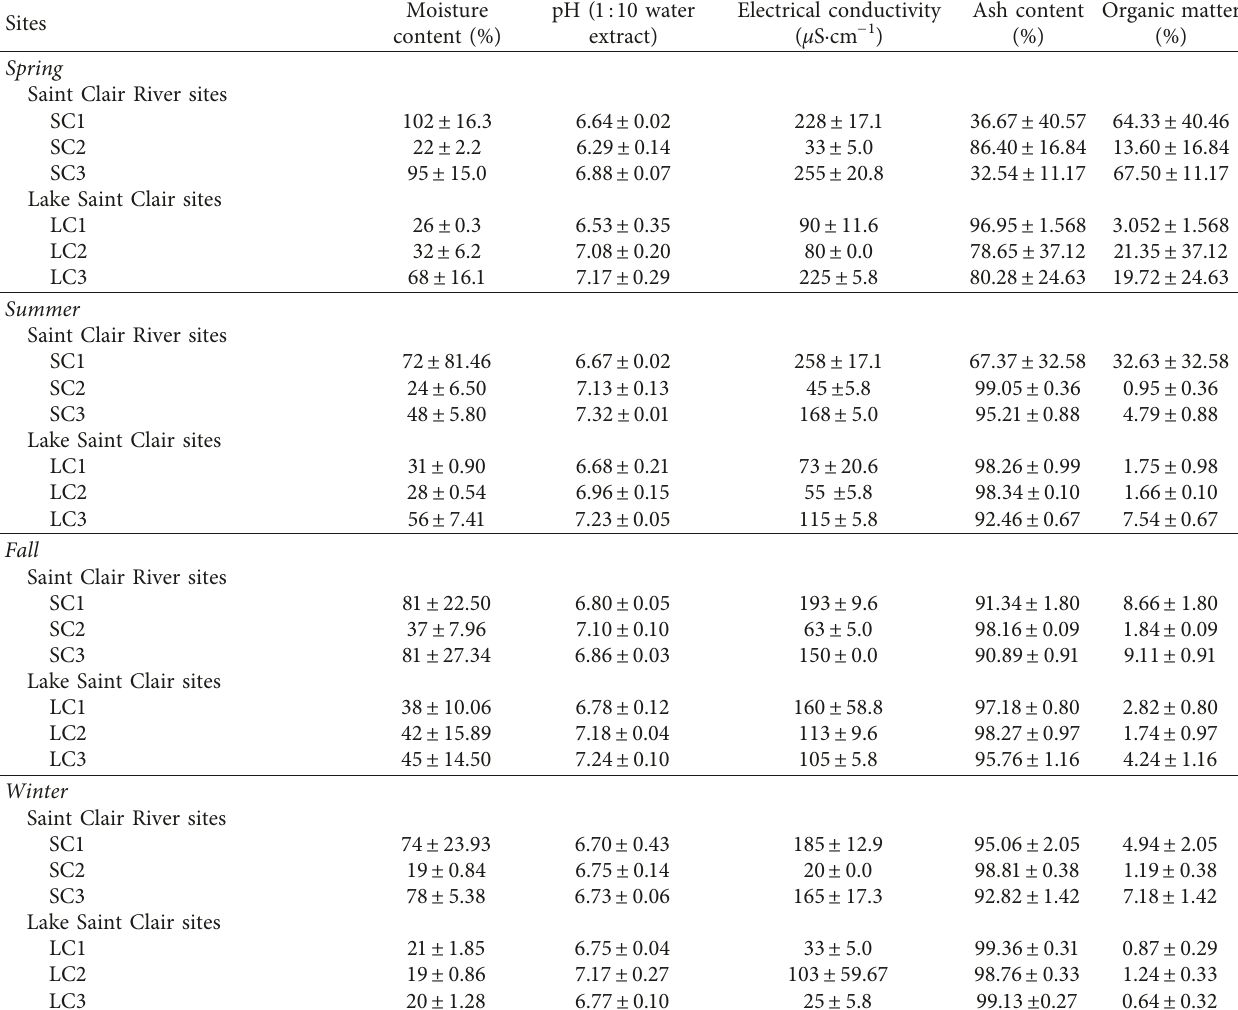
a Mean and standard deviation of three replicates are